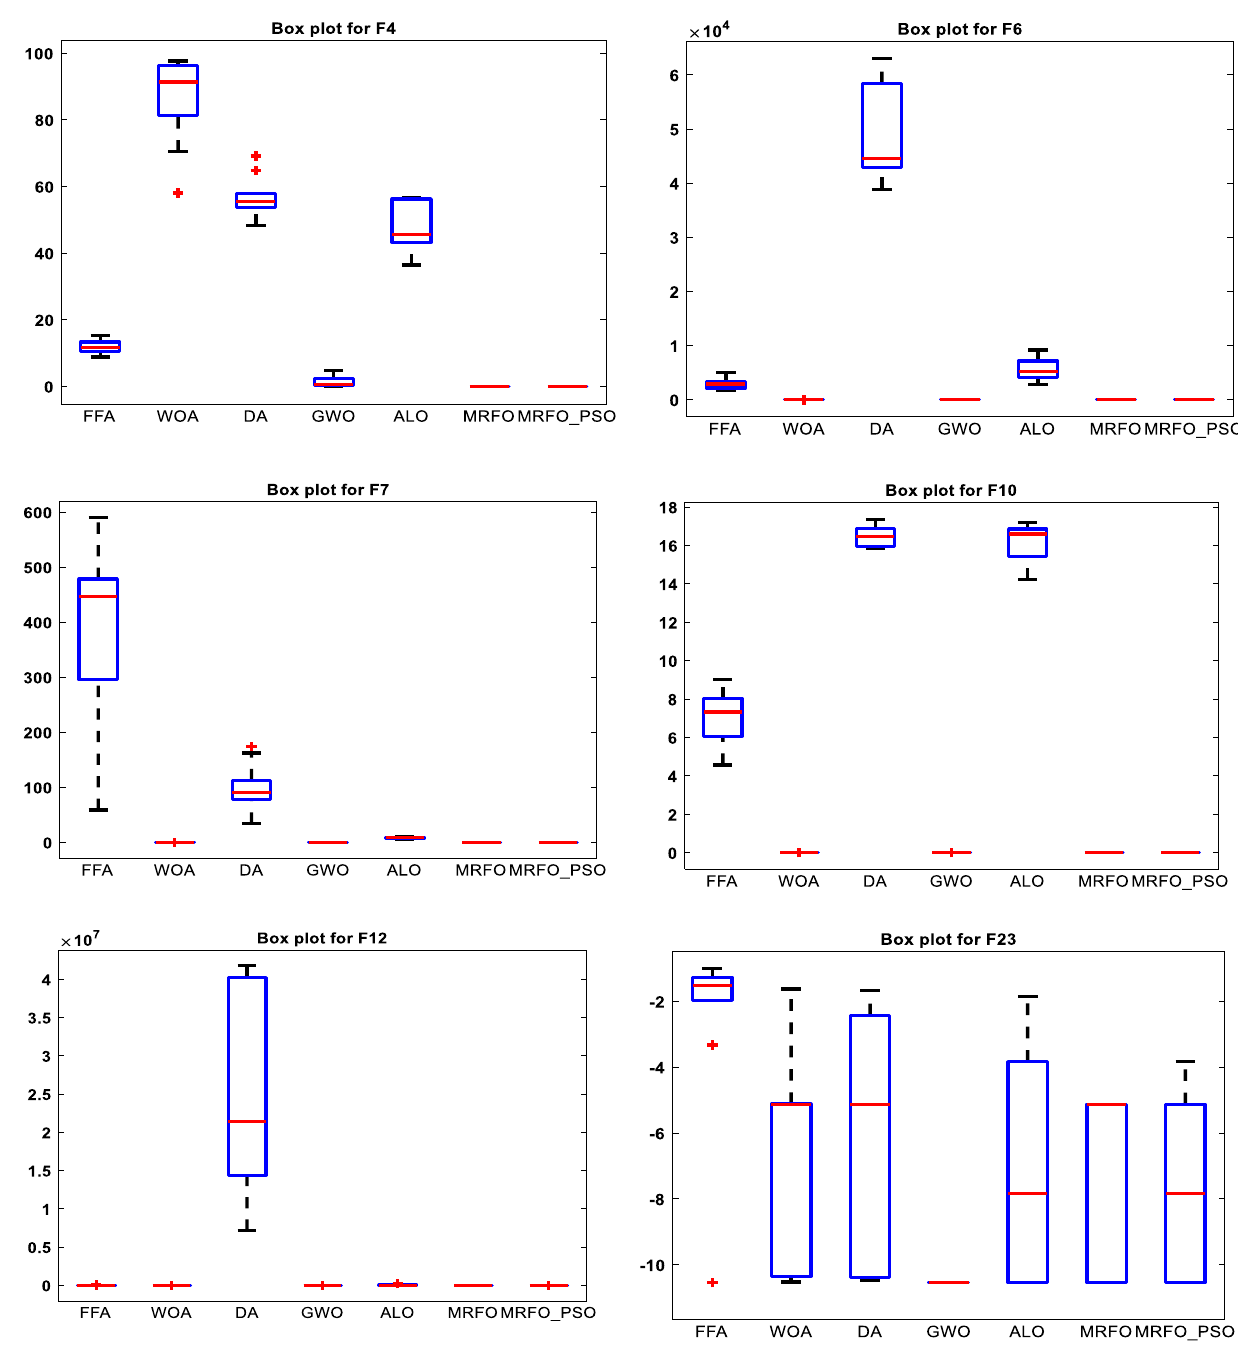
Fig. 3 Box plots for some selected